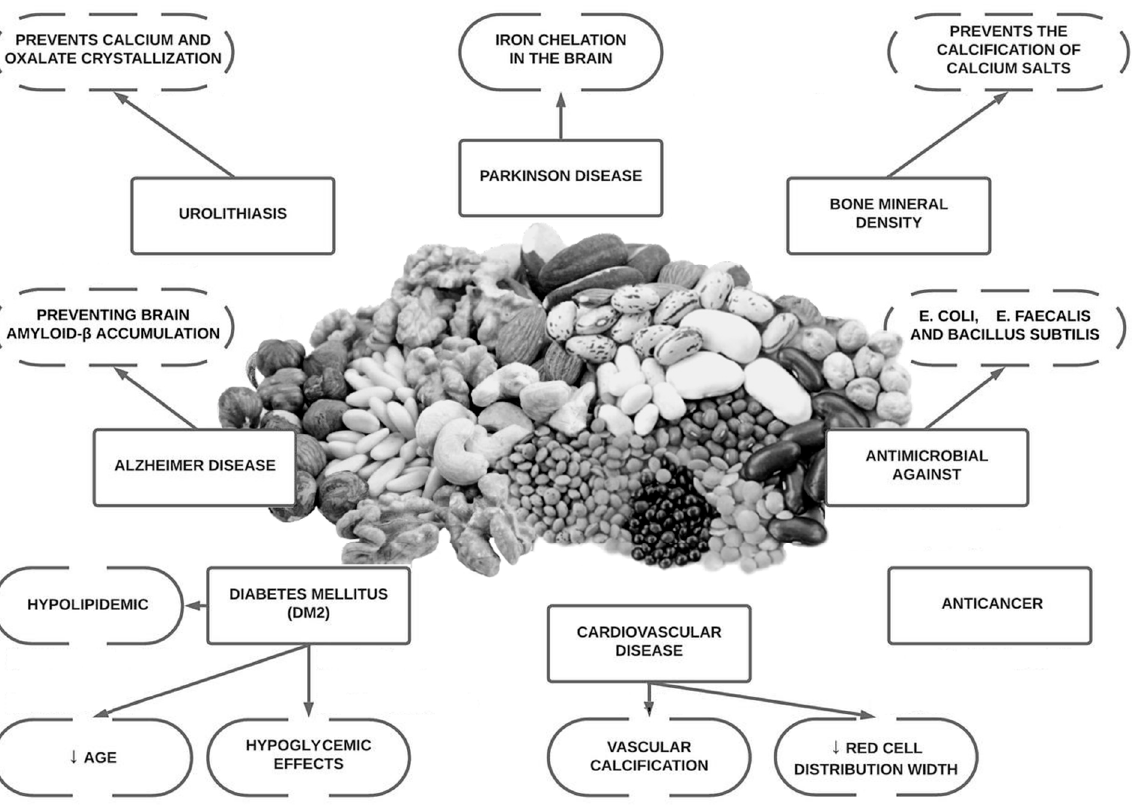
Figure 1. Overview of potential health benefits of